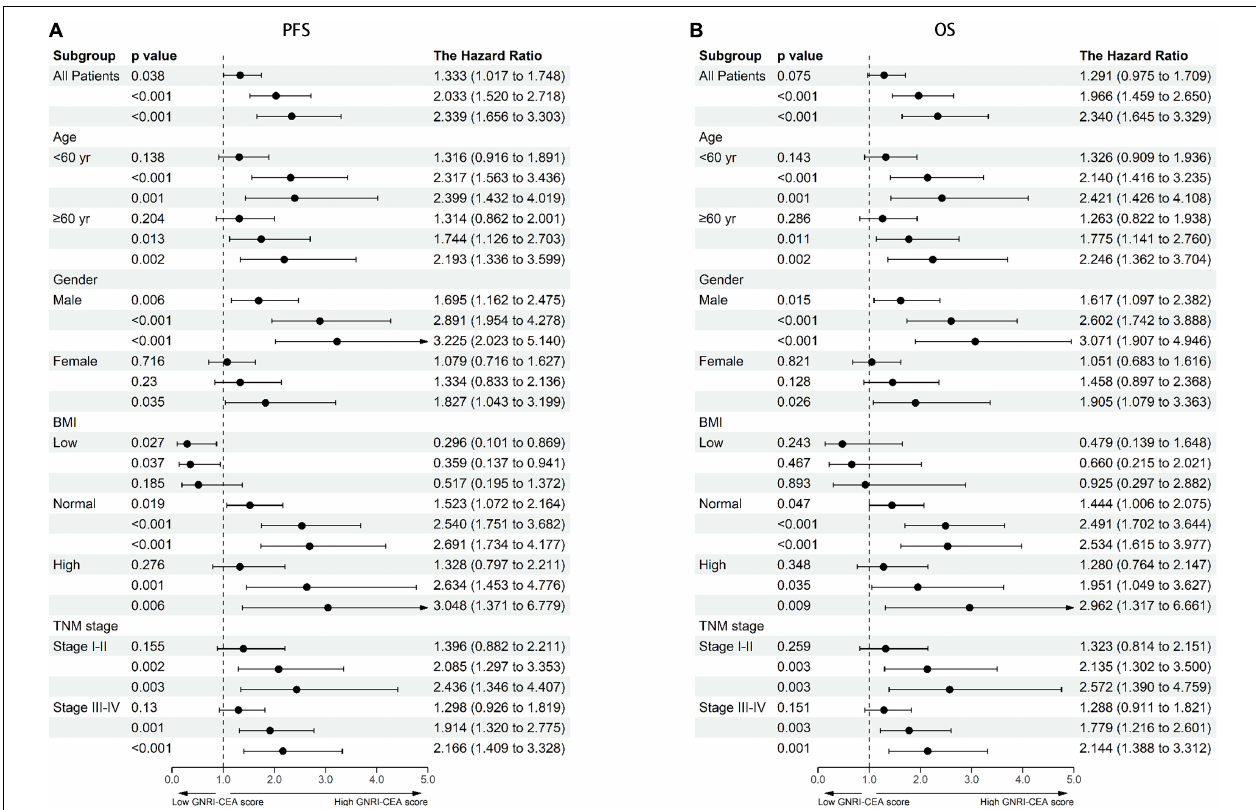
FIGURE 4 | Construction the novel prognostic nomograms in CRC patients. (A) The PFS nomogram; (B) the OS nomogram.